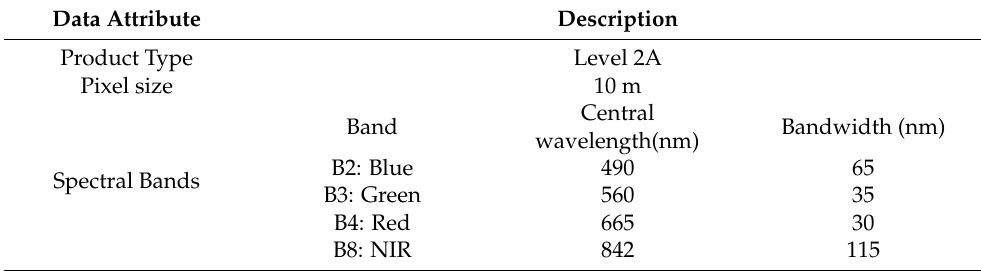
Table 1. Specifications of Sentinel-2